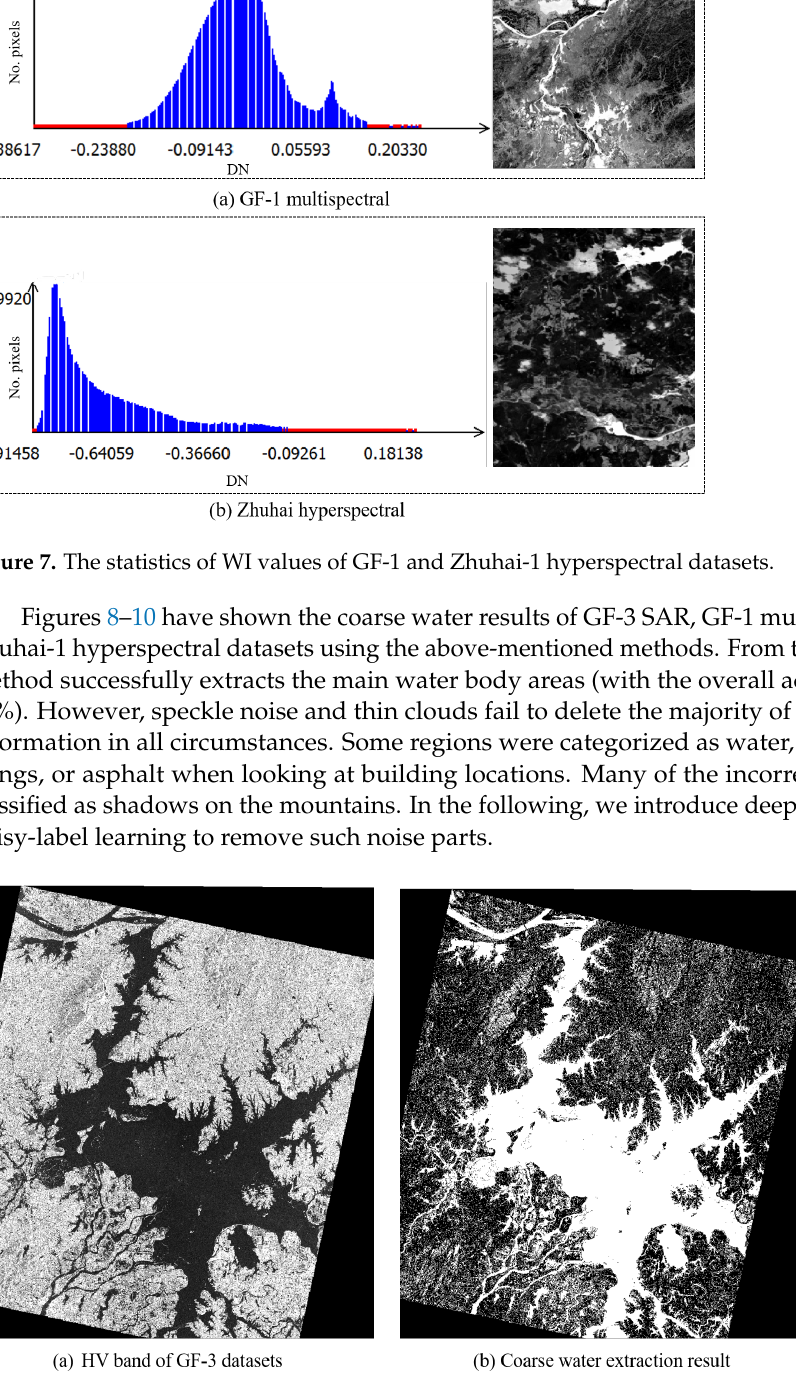
Figure 8. Coarse water extraction of GF-3